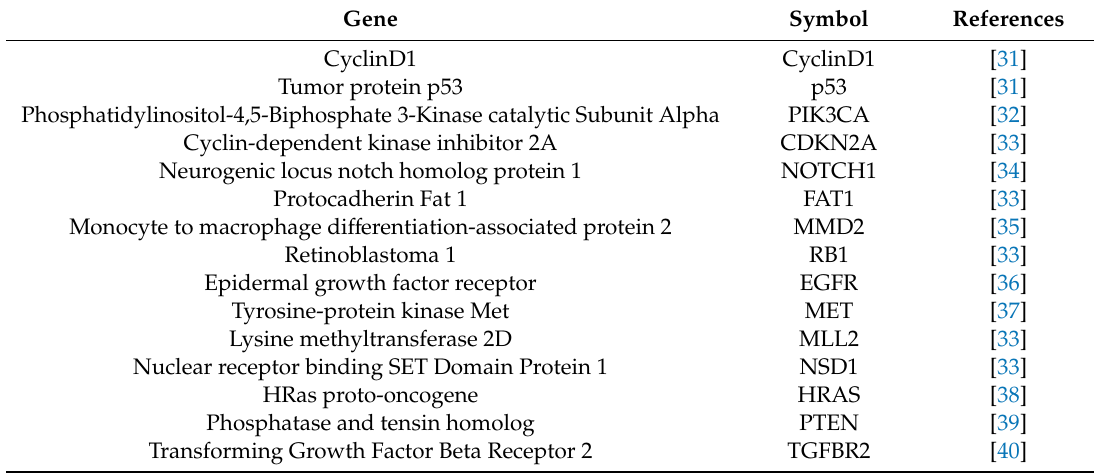
Table 1. A list of genes with a role in head and neck squamous cell carcinomas (HNSCC). Gene